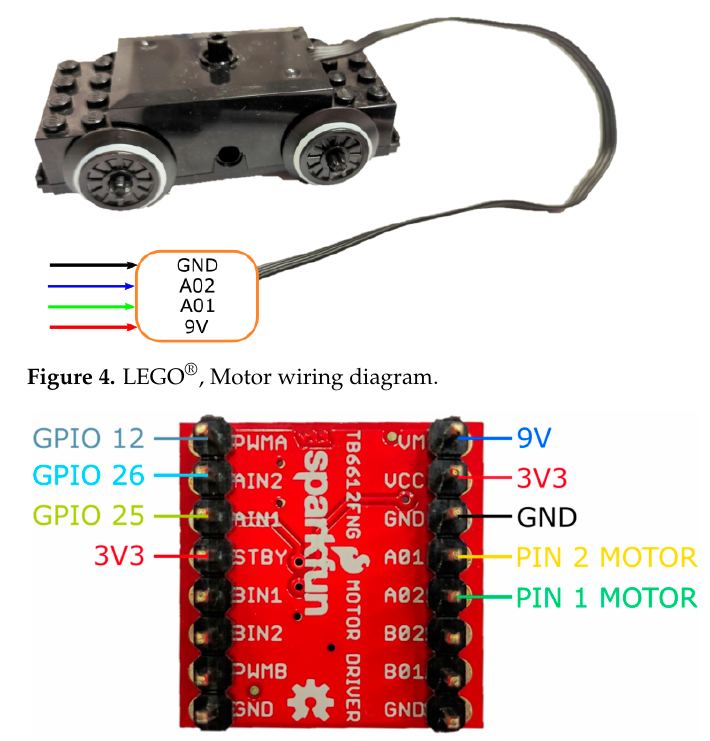
Figure 5. H-Bridge wiring